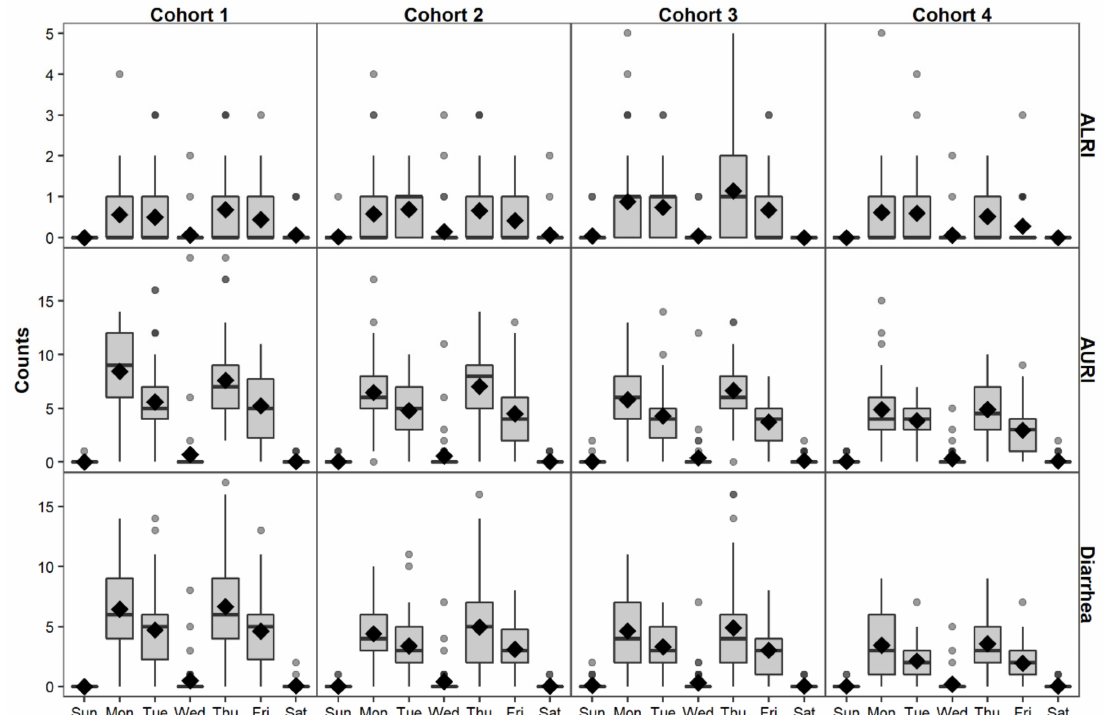
Figure 1. Daily reported cases of ALRI, AURI, and diarrhea per day of the week for each